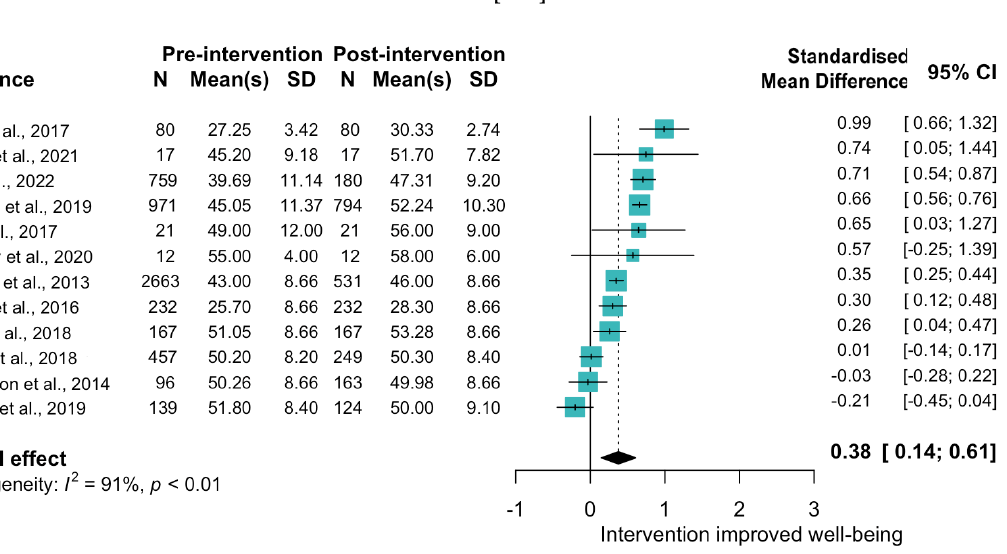
Figure 6. Forest plot indicating change in WEMWBS score from pre to post intervention for Theme 4: Physical activity interventions. Change indicated by standardised mean difference [185 – 187,190 – 198].